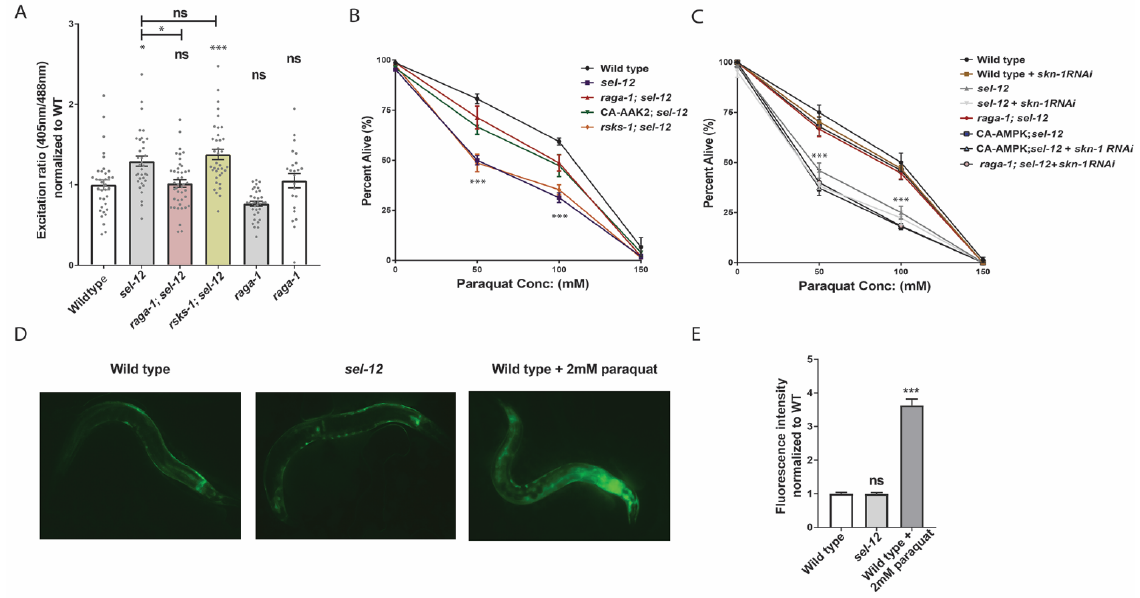
Figure 3. Inhibition of mTORC1 reduces mitochondrial ROS and rescues the hypersensitivity of sel-12 mutants to oxidative stress. ( A ) Relative mitochondrial oxidation levels in animals expressing mitochondria targeted roGFP1 in the TRNs. (n = 30). ( B ) Survival rate of animals following 24-h exposure to the oxidant paraquat (0, 50, 100, and 150 mM paraquat). (50 animals per strain, performed 3 times) ( C ) Paraquat survival curve in animals exposed to skn-1 or control RNAi. ( D , E ) Representative images ( D ) and quantification ( E ) of GFP fluorescence intensity in gst-4p ::GFP transgenic animals as a reporter for transcription of SKN-1/Nrf2 target GST-4. ns p > 0.05, * p < 0.05, *** p < 0.001 using one-way ANOVA with Kruskal-Wallis test ( A , D , E ) or two-way ANOVA with Bonferroni test ( B , C ). Comparisons are made to wild type unless otherwise indicated. Error bars indicate mean +/ −